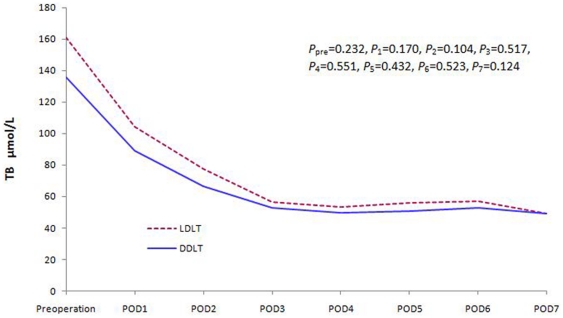
TB level changes during the first postoperative week (P
pre
 = 0.232, P
1 = 0.170, P
2 = 0.104, P
3 = 0.517, P
4 = 0.551, P
5 = 0.432, P
6 = 0.523, P
7 = 0.124).